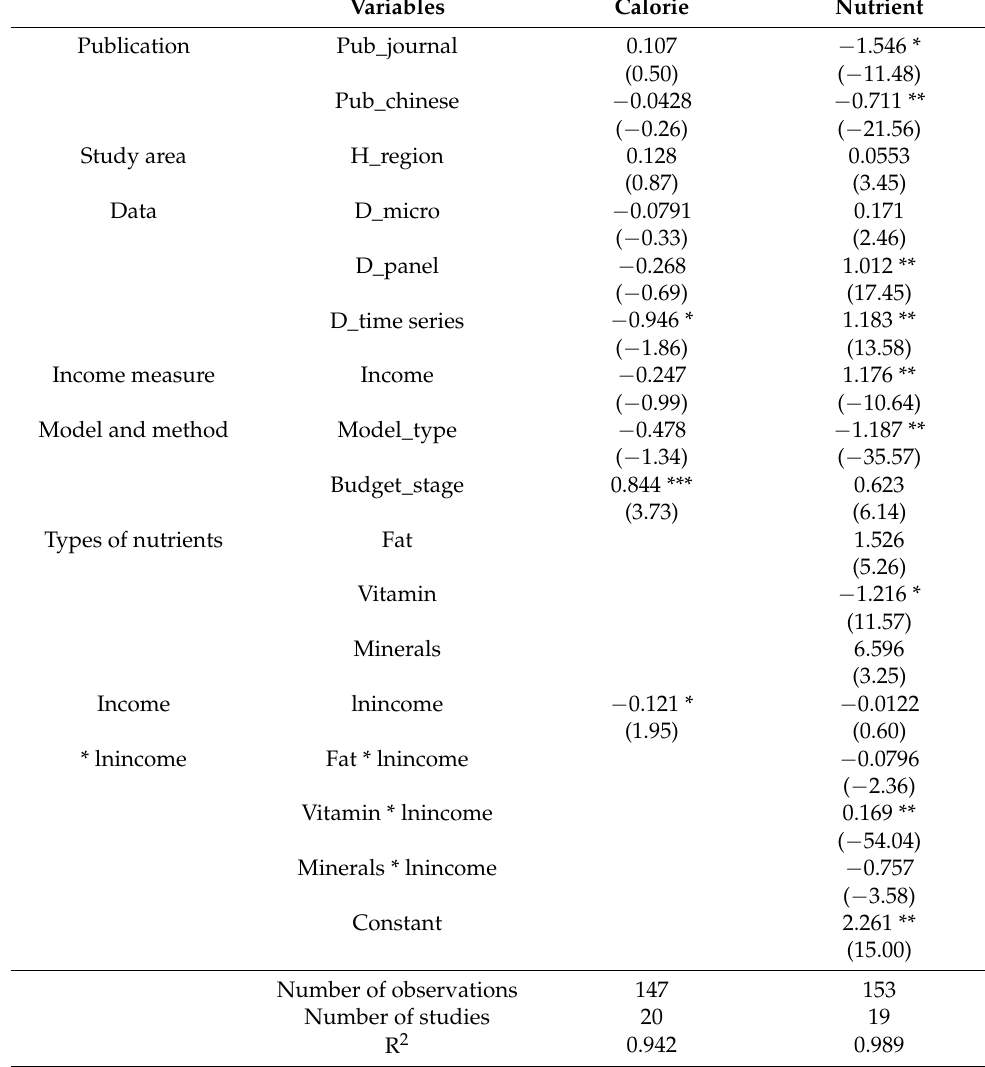
Table 5. Results from the meta-regressions of calorie-, nutrient–income